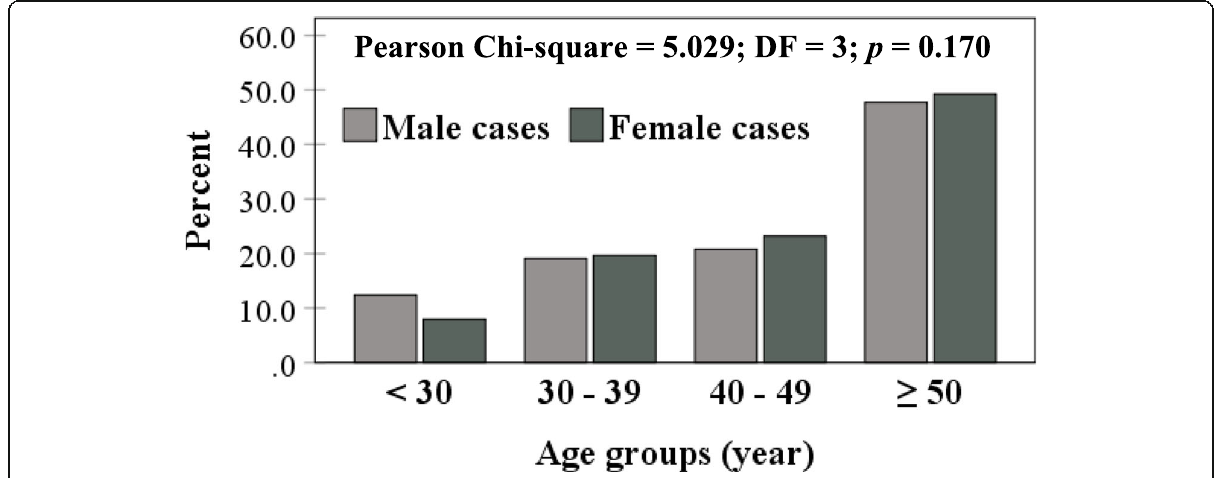
Fig. 6 COVID-19 cases distributed according to age groups and gender